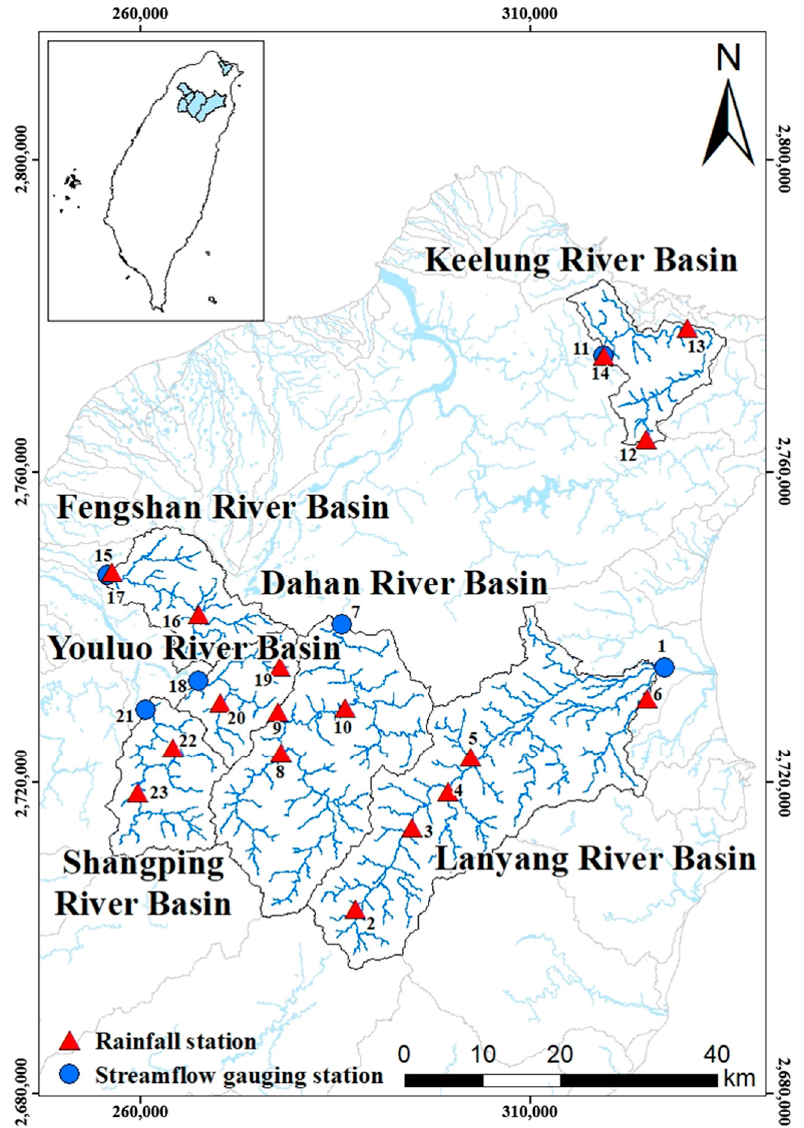
Figure 1. Location of study river basins and gauging stations.